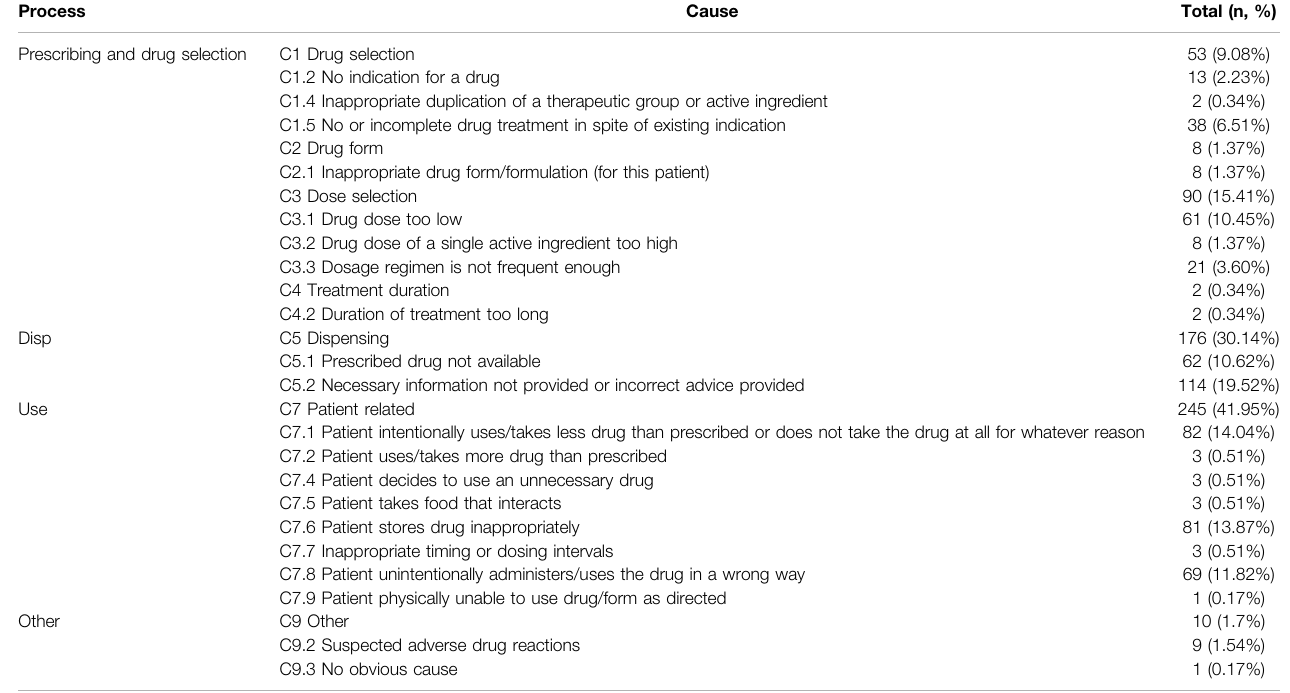
TABLE 3 | The causes distribution of DRPs in children with chronic diseases in the